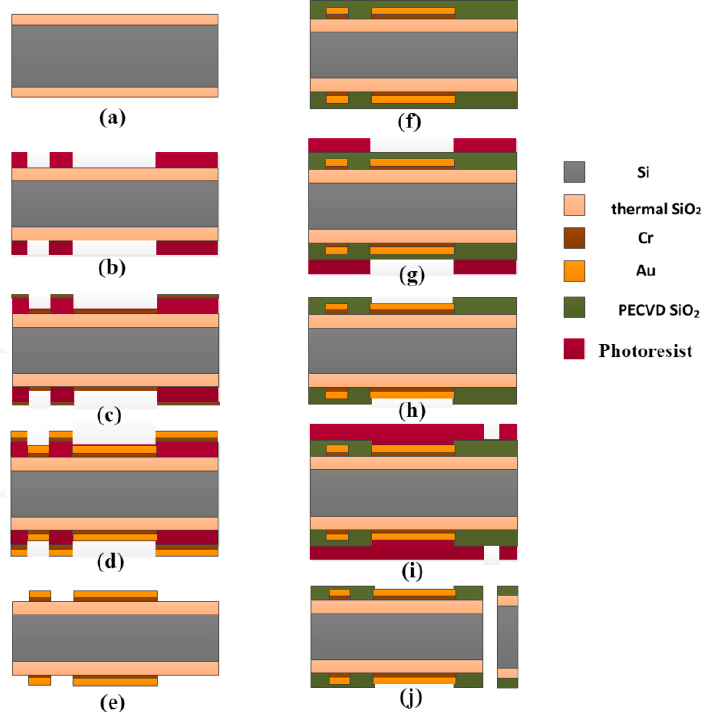
Figure 3. Schematic diagram of the process flow: ( a ) thermal oxidation; ( b ) spinning photoresist and ( i ) spinning photoresist for DRIE; ( j ) DRIE and device release.